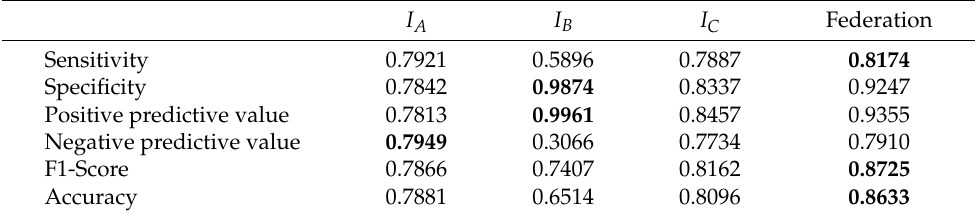
Table 2. Classification results reached on the test set for patch-level ROI selection on the spitzoid melanocytic lesions dataset; I A , I B , and I C : centralized setups at each local institution; Federation: decentralized federated setup, leveraging all institutions’ data. I A I B I C